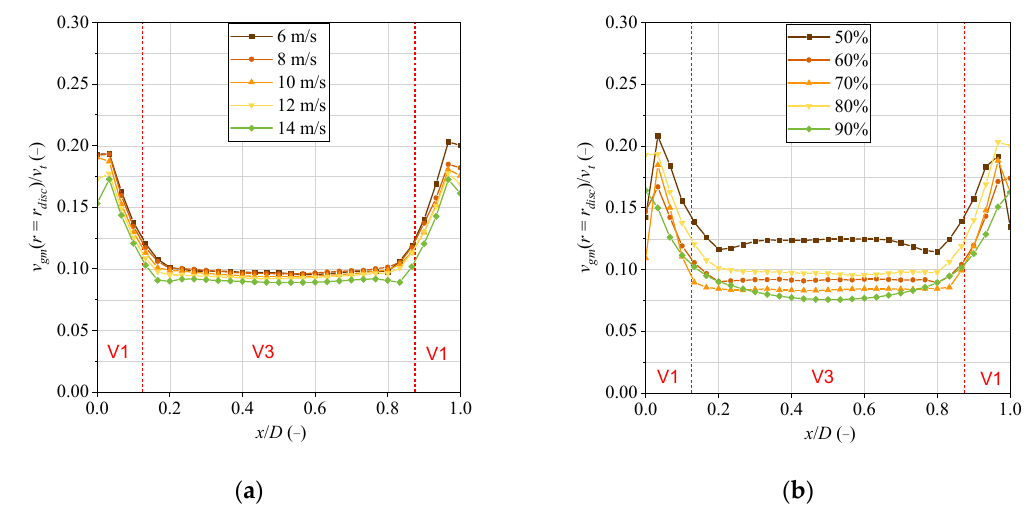
Figure 10. Average grinding media velocity between the discs at the radius of the disc circumference ( r = 0.36). The red vertical lines show the border between volumes V1 and V3: ( a ) for varied stirrer tip speeds; ( b ) for varied grinding media fillings.